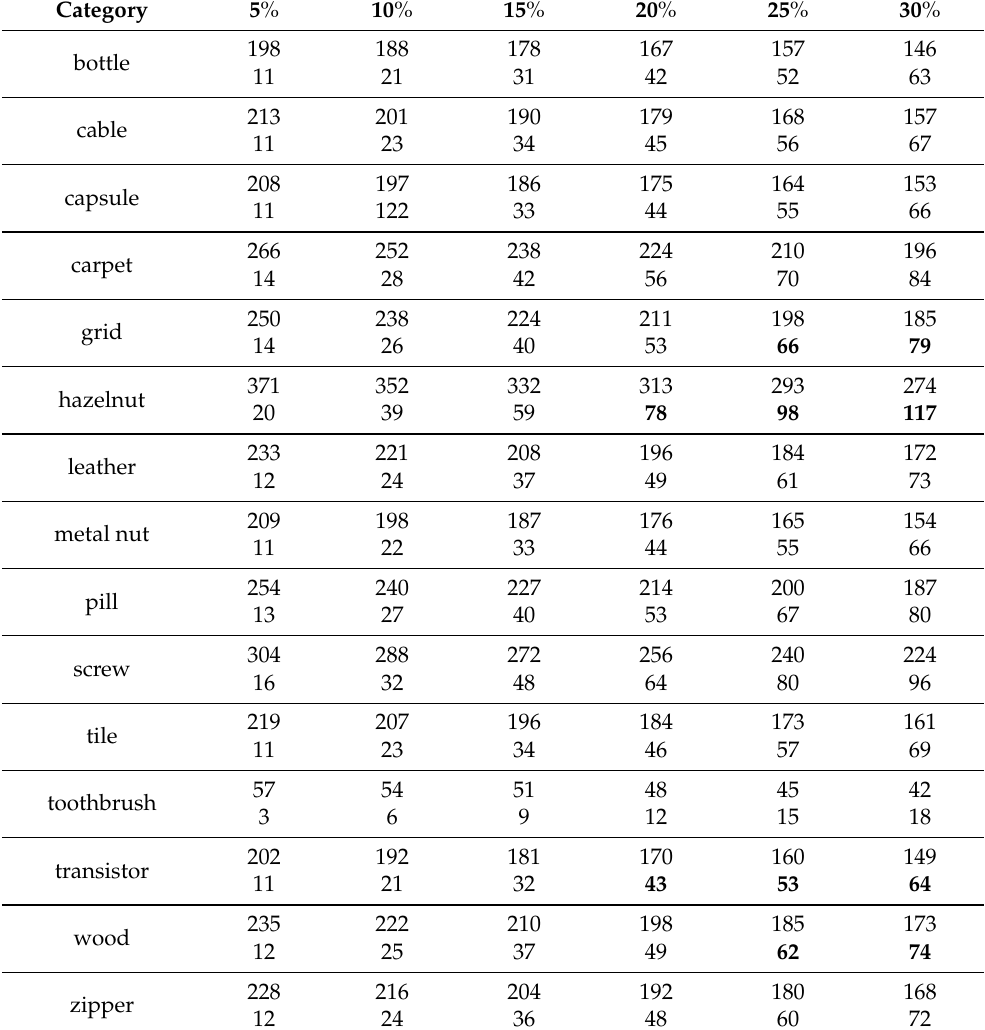
Table 1. Components of the dirty MVTec dataset. The upper row is the number of normal samples and the lower row is the number of anomaly samples. The bolded font means that the number of the anomaly samples in the test set were insufficient and we used data augmentation for them. Category 5 % 10 % 15 % 20 %